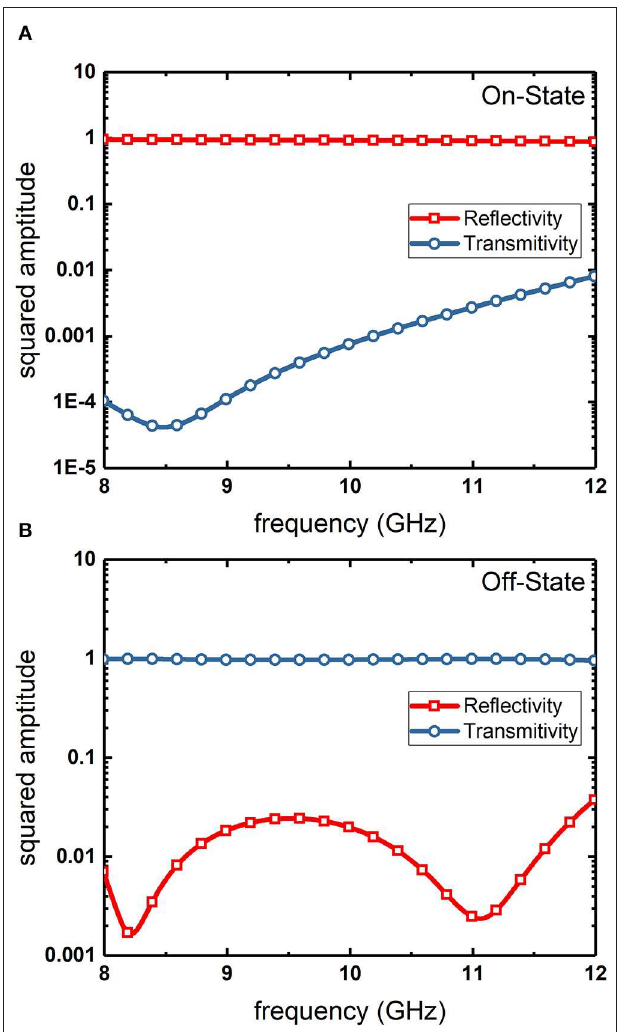
FIGURE 2 | The simulated transmission (blue ring dot lines) and reflection (red square dot lines) spectra of the switchable metasurface when the loaded PIN diodes are (A) on-state and (B) off-state.